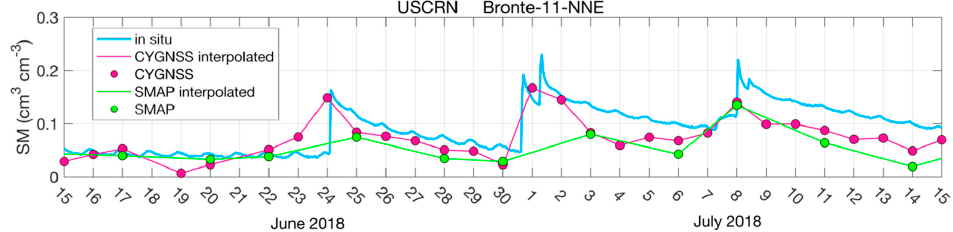
Figure 12. Time series of CYGNSS (pink dots) and SMAP (green dots) soil moisture retrievals and in-situ soil moisture observations (blue line) from the USCRN Bronte-11-NNE station. Pink and green lines interpolate between the CYGNSS and SMAP observations, respectively. The shortened time series shows the increased temporal resolution of the CYGNSS retrievals relative to SMAP.